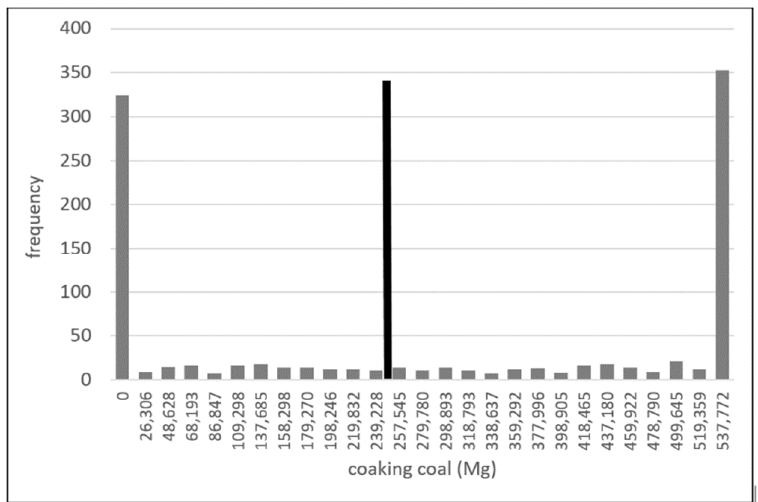
Figure 9. Histogram showing frequencies of achieving given quantity of sales of coking coal for mine “F” with σ yprog .